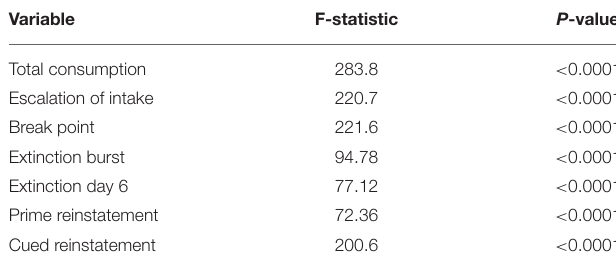
TABLE 2 | ANOVA global F-statistics and associated p -values for each behavioral measure.